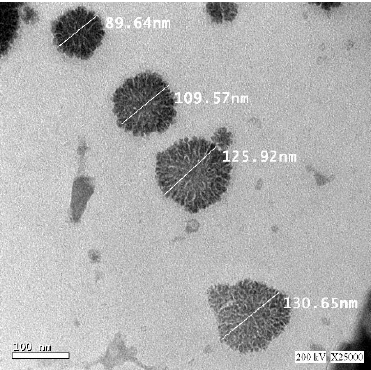
Figure 3. Transmission electron microscope images of optimized FLB TRFs at 25,000× magnification.